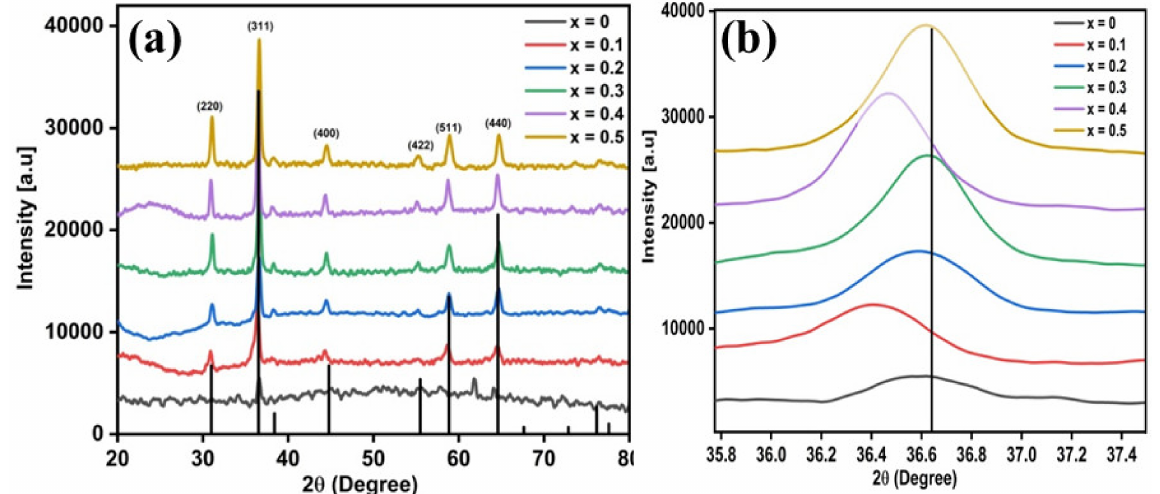
Figure 1. ( a ) XRD patterns of pure cobalt ferrite ( x = 0) and doped CoFe 2 − 2x Li x Zn x O 4 ( x = 0.1–0.5) nano powder; ( b ) Zoom of the peak corresponding to the plane (311) of doped CoLi x Zn x Fe 2 − 2x O 4 ( x = 0–0.5) nano